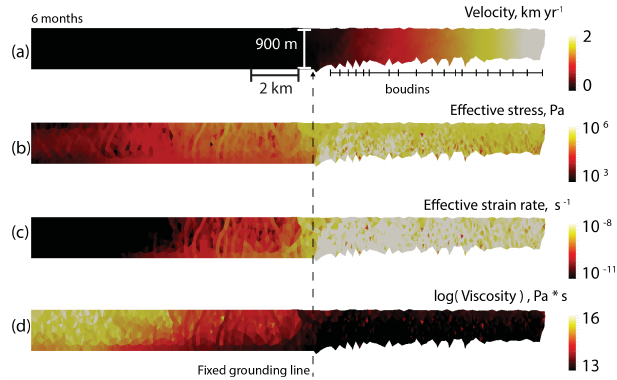
Figure 6. Simulation of semi-brittle wedge of ice after 6 months of model time, undergoing a jump in boundary conditions from freely slipping on the basal side (left of grounding line – dashed arrow) to floating in the ocean (right of grounding line). The horizontal velocity (a) is fixed at x = 0 and free elsewhere, while the vertical velocity is free at x = 0 and fixed to 0 up to the grounding line. The gradient in thickness drives the flow of ice over the grounding line where ice experiences a transition to stress boundary conditions that represent floatation and 1m tides. Dashed bars in the floating tongue show the development of boudins. The effective stress (b) and strain rate (c) fields both show orders-of-magnitude increases at the grounding line: the jump in strain rate allows the ice to be evalu- ated as brittle in DES, and the associated stresses are high enough to reach yield (see Fig. 6). The corresponding viscosities (d) just up- stream of the grounding line are high and decrease 3 orders of mag- nitude as the ice expands out into the ocean under its own